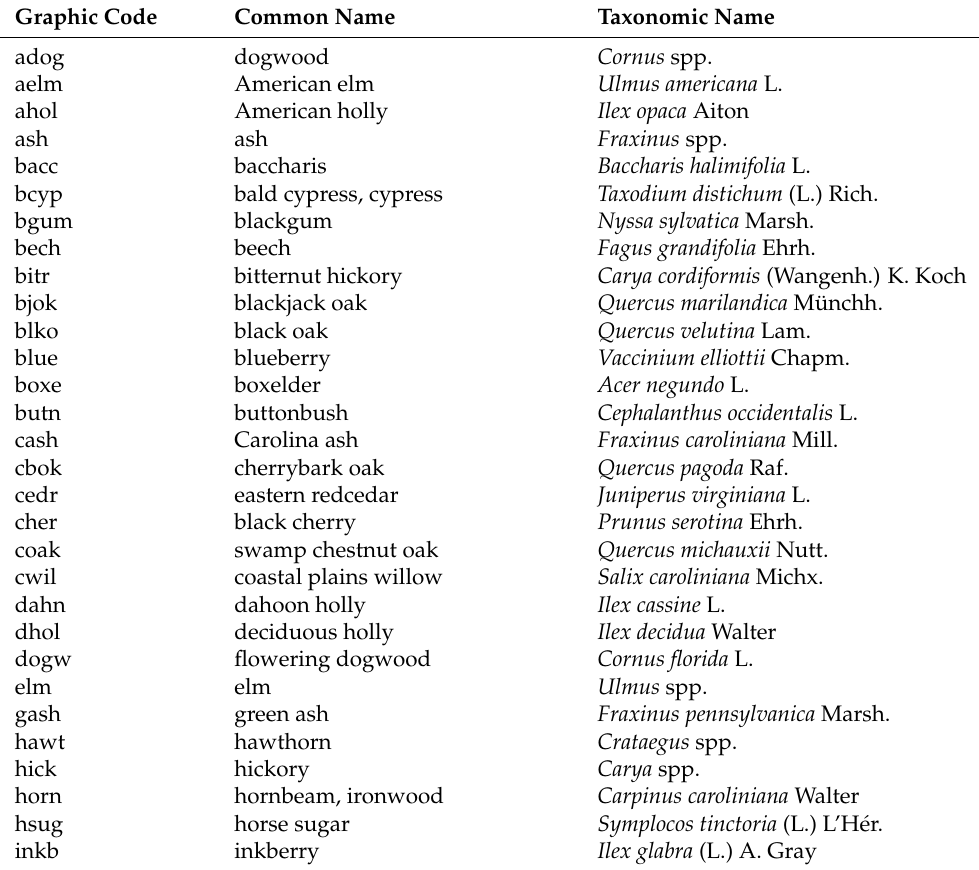
Table 1. A complete list of graphics code, common name, and taxonomic name for all species in this